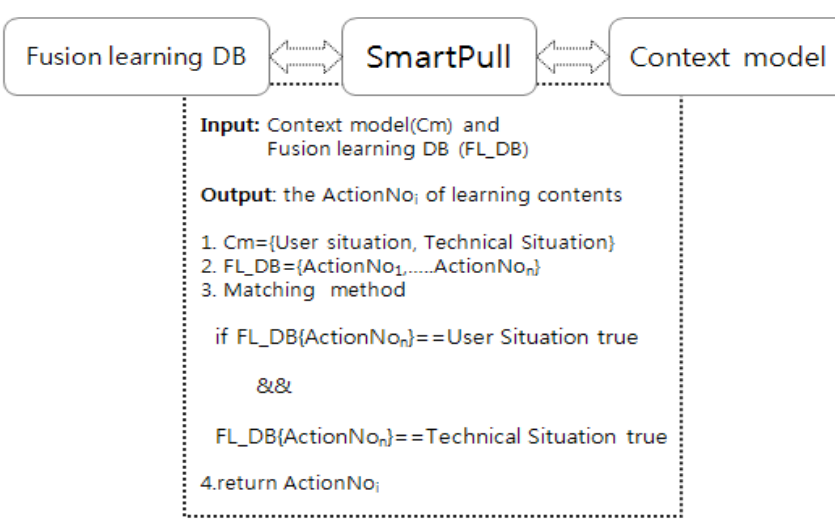
Figure 4. Matching search of Smart